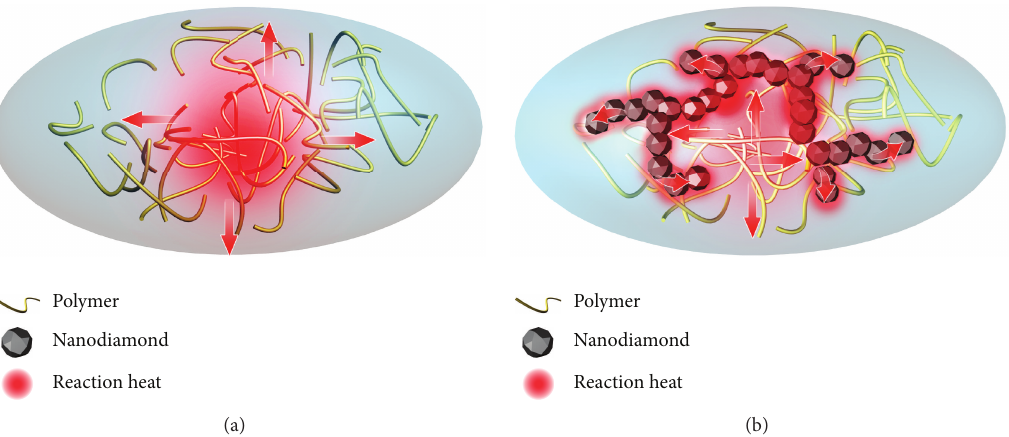
Figure 7: Heat dissipation model in the base materialin the (a) absence and (b) presence of nanodiamonds.